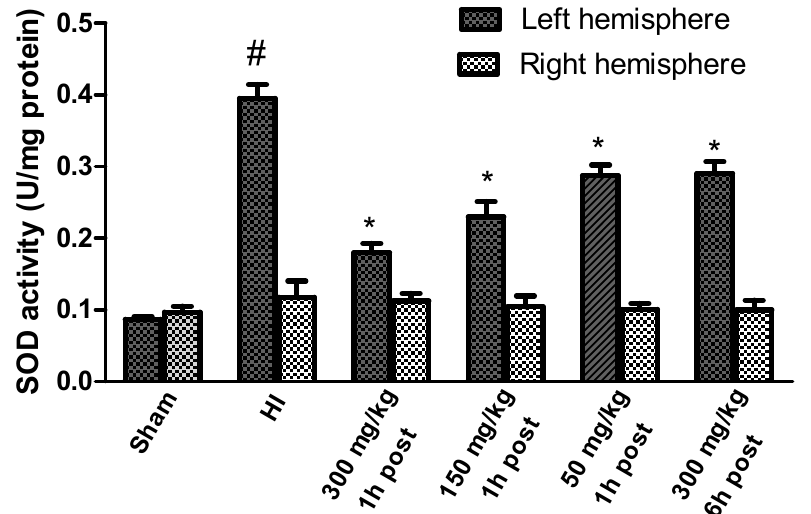
Figure 4. Effect of KYNA application on HI-induced changes in SOD activity. The results are presented as the means ± SEM, n = 6; statistically significant differences: * p < 0.001 compared to the HI group; # p < 0.001 compared to the sham-operated group.